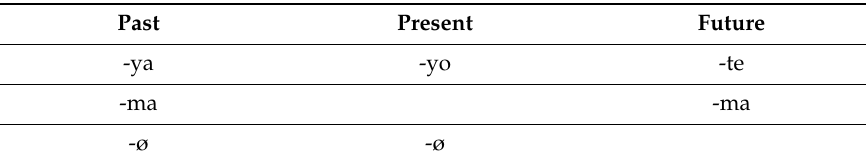
Table 1. Tense marking in Rengma.